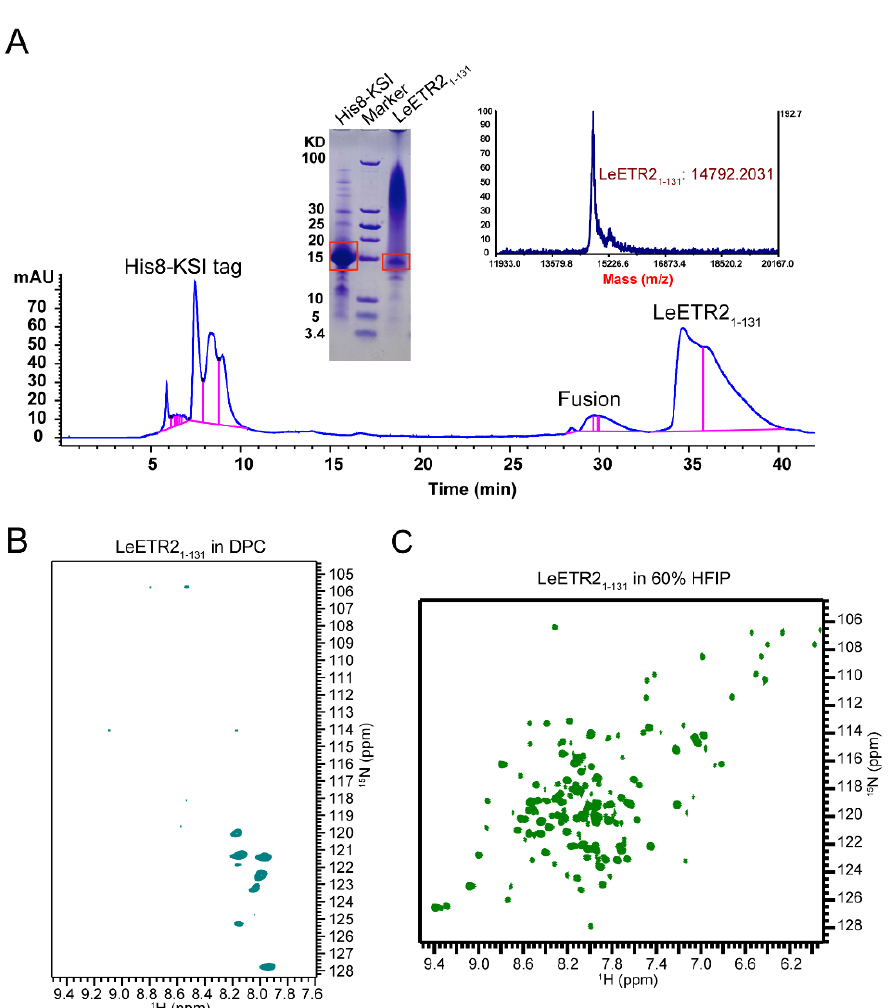
Figure 2. The expression and NMR detection of LeETR2 1–131 using the Bruker AVANCE 600 MHz spectrometer. ( A ) The HPLC plot of purification procedure for LeETR2 1–131 , which were detected using mass spectrometry and SDS-PAGE. ( B ) The NMR TROSY-HSQC spectrum of LeETR2 1–131 in DPC micelles, which was purified from reversed-phase HPLC. The sample could not be well dissolved in this type of detergent. ( C ) The NMR TROSY-HSQC spectrum of LeETR2 1–131 in 60% HFIP. The sample could be well dissolved in this type of organic solvent compared with given detergents.